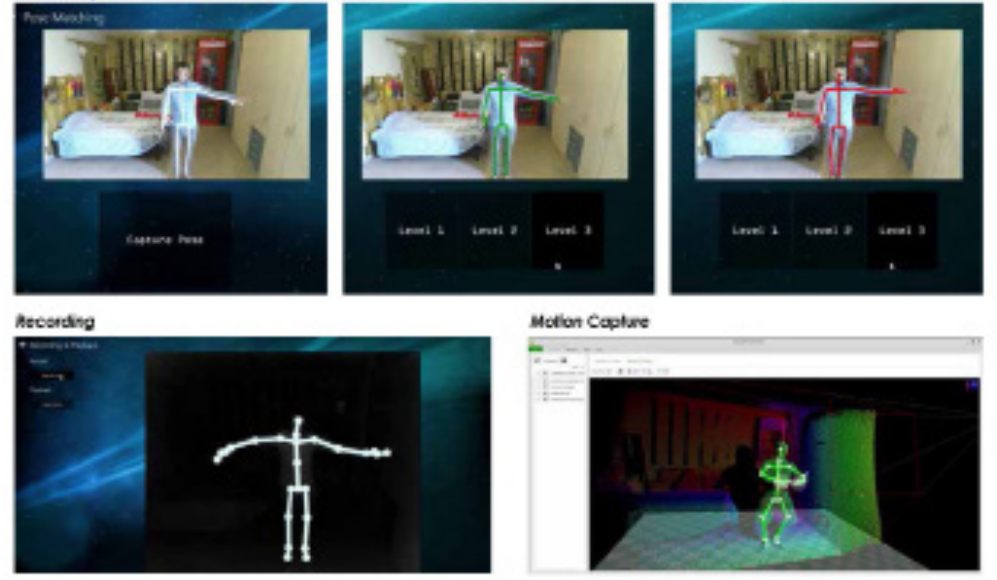
Fig. 10 Zambonini A., photocomposite. Motion capturing technologies and devices have been used for capturing a pose. In the left image the button “Capture pose” will fix the pose of the user. The central image shows the correct position being respected by the user, the image on the right instead is reflecting a possible distraction by the user,